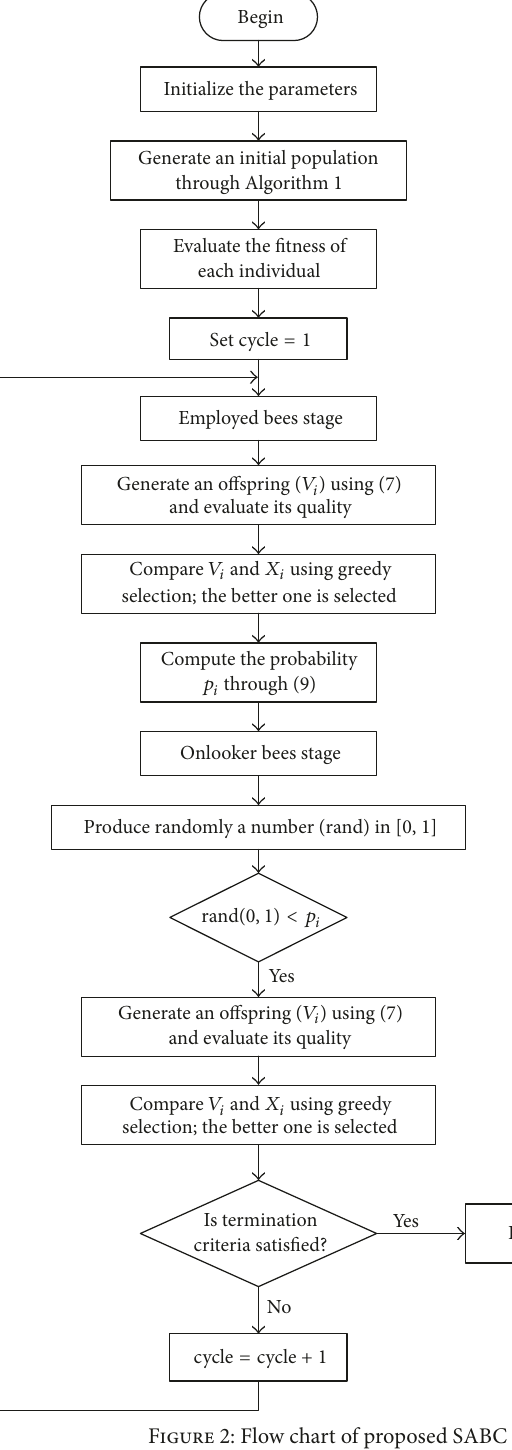
Figure 2: Flow chart of proposed SABC